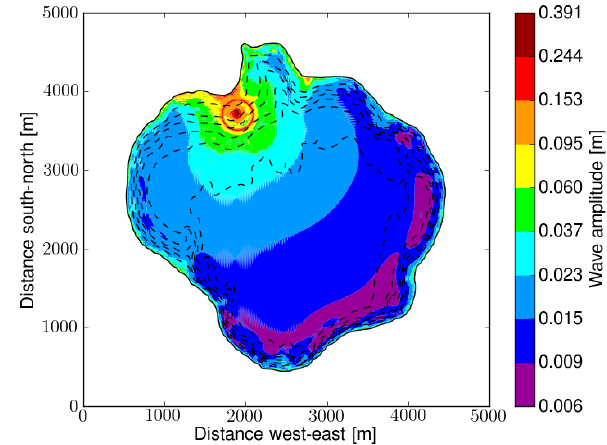
Fig. 4. Simulated maximum wave amplitude in Karymskoye lake during the 1996 eruption. The bathymetry is represented by dashed lines, which are drawn at 10 m depth intervals.